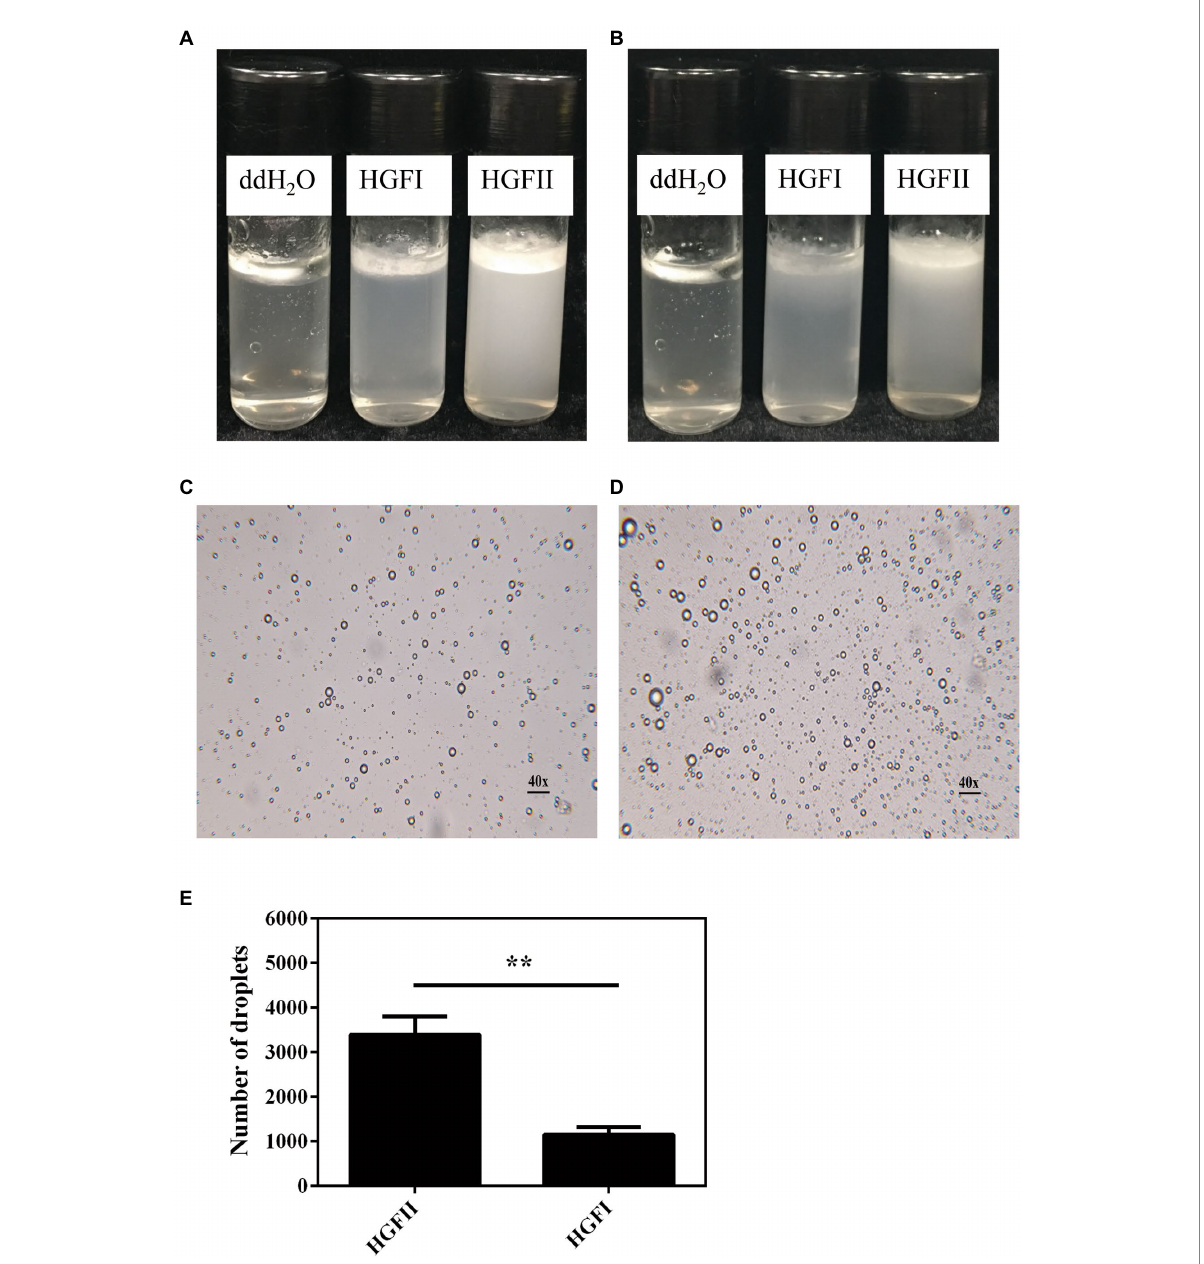
FIGURE 9 Emulsification of an oil–water mixed system after dispersion with HGFII and HGFI, respectively. Images were taken after the vials had been allowed to settle for 24 h (A) and 72 h (B) at room temperature. Microscope images of the oil droplets treated with HGFI (C) and HGFII (D) after standing for 24 h at room temperature. Scale label: 40 ◊ magnification. (E) Statistical analysis of the oil droplet numbers corresponding to image (C,D) with Image J and GraphPad Prism 6.04 programs [Statistically significant difference: ** p < 0.05 (Unpaired t-